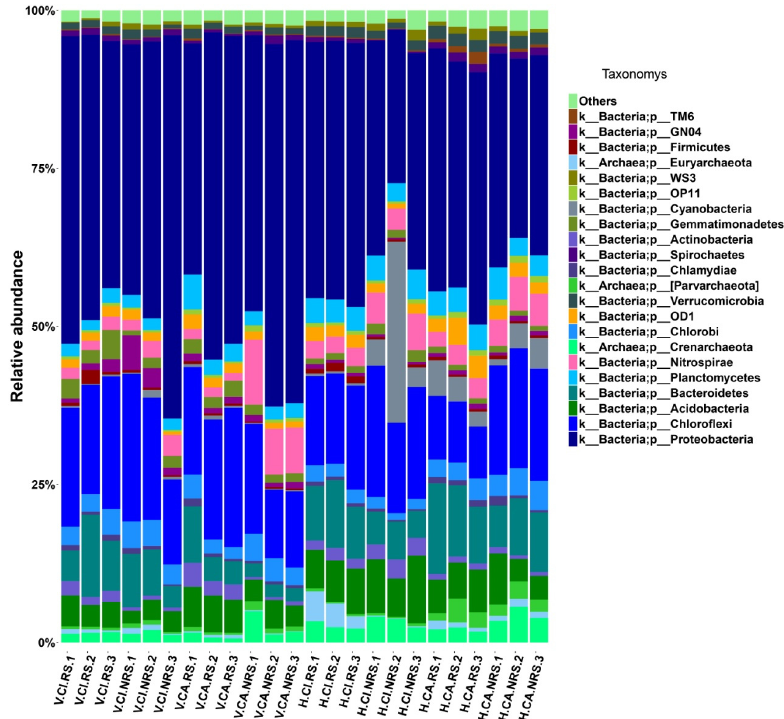
Figure 2. Relative abundance (%) of dominant microbial taxa across all analyzed sediments revealed by 16S rRNA MiSeq sequencing, at phylum level, mean relative abundance > 1%. In the sample number: V = VSFCW; H = HSFCW; CI = Canna indica ; CA = Cyperus alternifolius ; RS = rhizosphere; NRS = non-rhizosphere; three duplicates in each zone were numbered with 1, 2 and 3. Int. J. Environ. Res. Public Health 2019 , 16 , x At the genus level, members from Nitrospira , Leptolyngbya , Thiobacillus and Geobacter were most frequently detected (Figure 3). Leptolyngbya showed its highest abundance (17 ± 3.0%) in NRS of CI in VSFCW and the abundance in NRS was higher than that in RS of two plant species. Thiobacillus showed the highest abundance (19.8 ± 1.7%) in CA RS in VSFCW and the abundance in RS was higher than that in NRS for two plant species. The relative abundance of Nitrospira in NRS was higher than that in RS. Geobacter showed the opposite trend with Nitrospira in NRS and RS in two plants, the abundance in RS is higher than that in NRS in two plants. Dechloromonas showed higher abundance in V.CI.NRS samples.